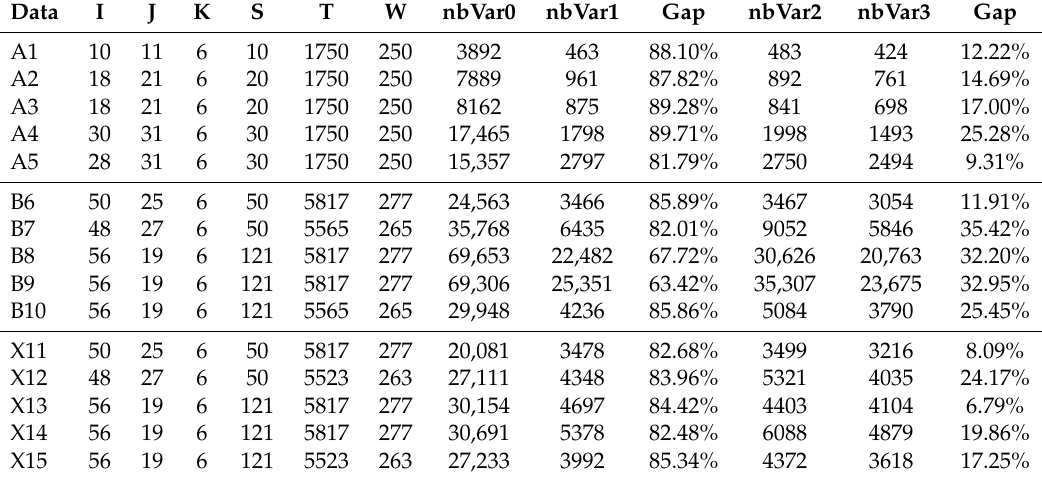
Table 5. Characteristics of the instances of the EURO/ROADEF Challenge 2010: values of I,J,K,S,T,W as defined in Table 1, nbVar0 and nbVar2 are respectively the total number of variables without and with pre-processing of Proposition 3, i.e., the total amplitude of the time windows, nbVar1 and nbVar3 are respectively the remaining variable after Cplex pre-processing with and without pre-processing of Proposition 3. Gaps show the improvements due to Proposition